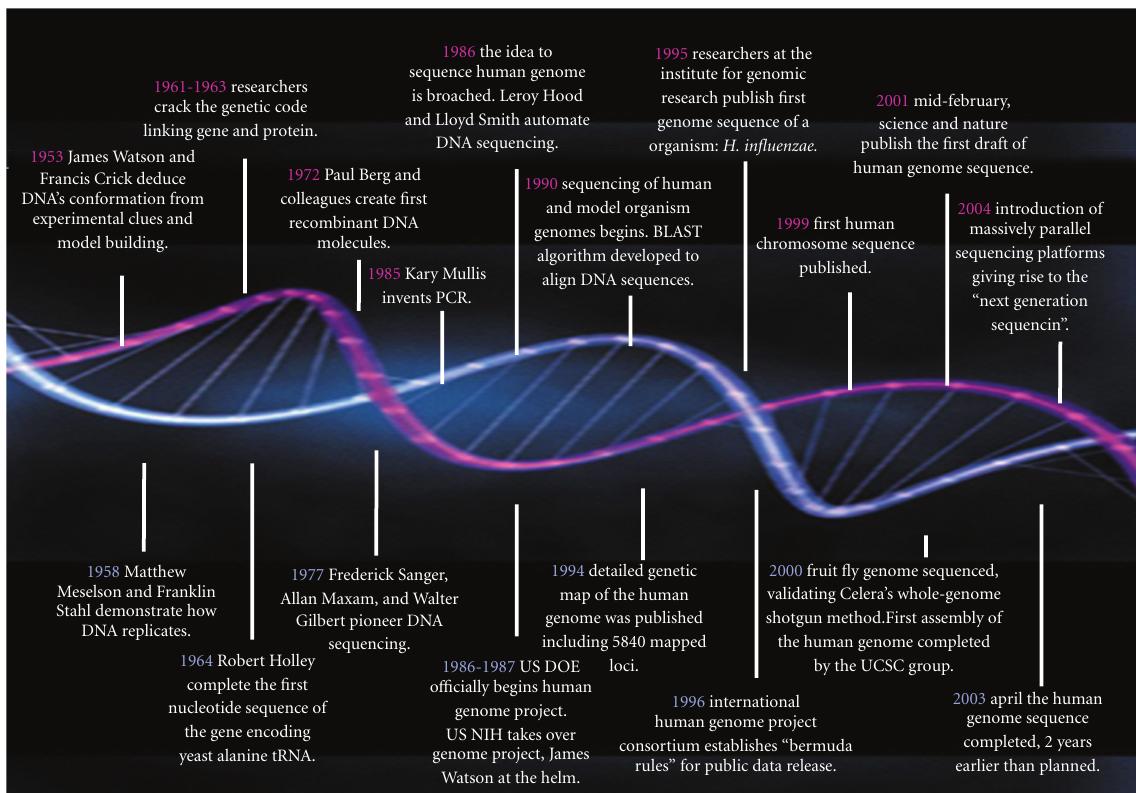
Figure 1: Evolution of DNA